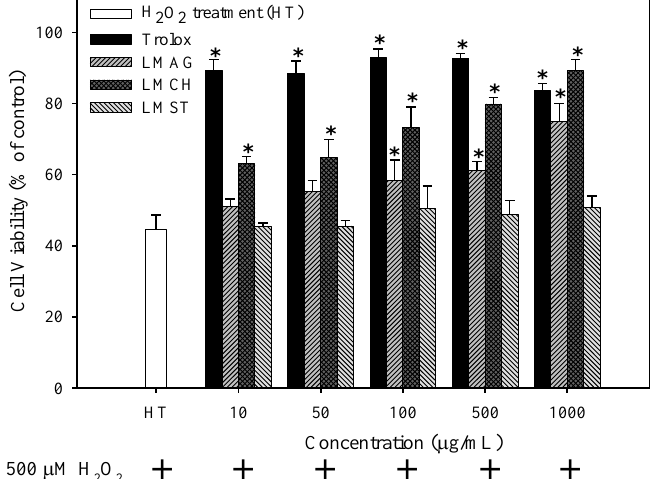
O . Data are expressed as mean 2 2 O treatment. 2 2